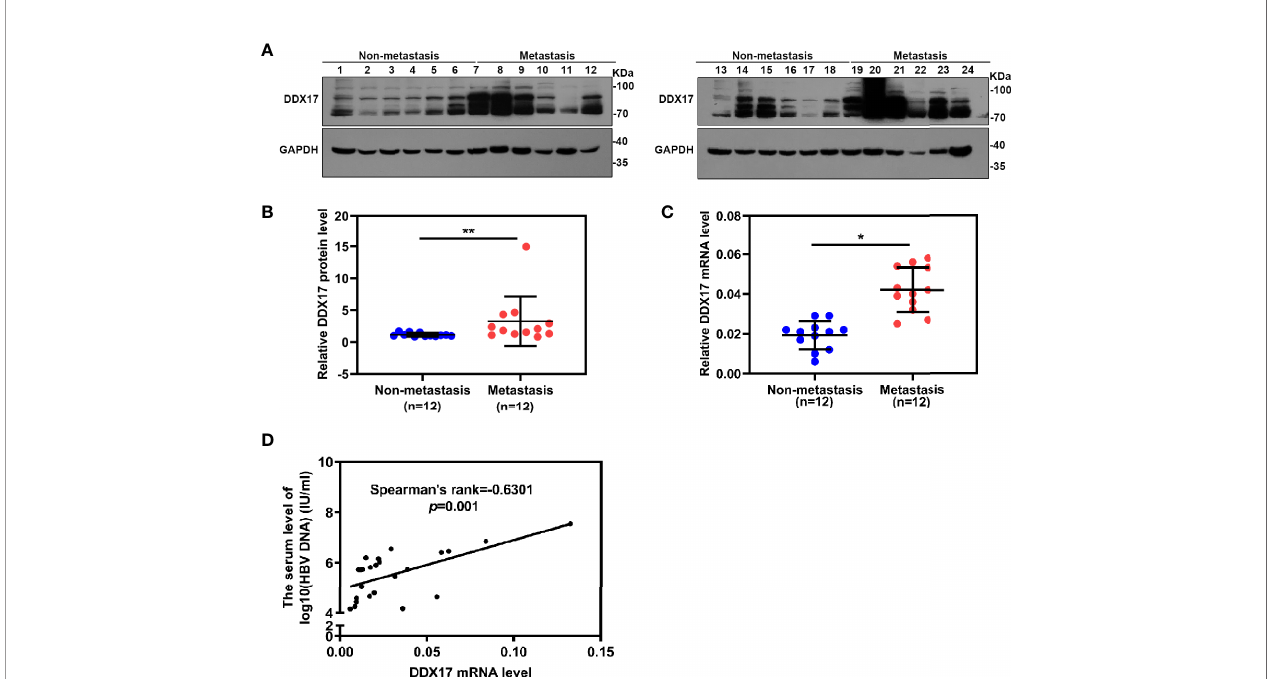
FIGURE 8 | DDX17 play an important role in HBV-related HCC metastasis. (A, B) Western blot assay was subjected to examined the protein level of DDX17 in HBV- related HCC tissue samples, GAPDH was used as internal quantitative controls. (C) Real-time PCR was subjected to examined the mRNA level of DDX17 in HBV-related HCC tissue samples, b -actin was used as the internal quantitative controls. (D) Correlation between the serum HBV DNA levels and the liver DDX17 levels in HBV-related HCC patients. HBV DNA levels was log10-transformed. Correlation coef fi cients (r) and two-tailed P values were evaluated by Pearson ’ s test. *P < 0.05, **P <